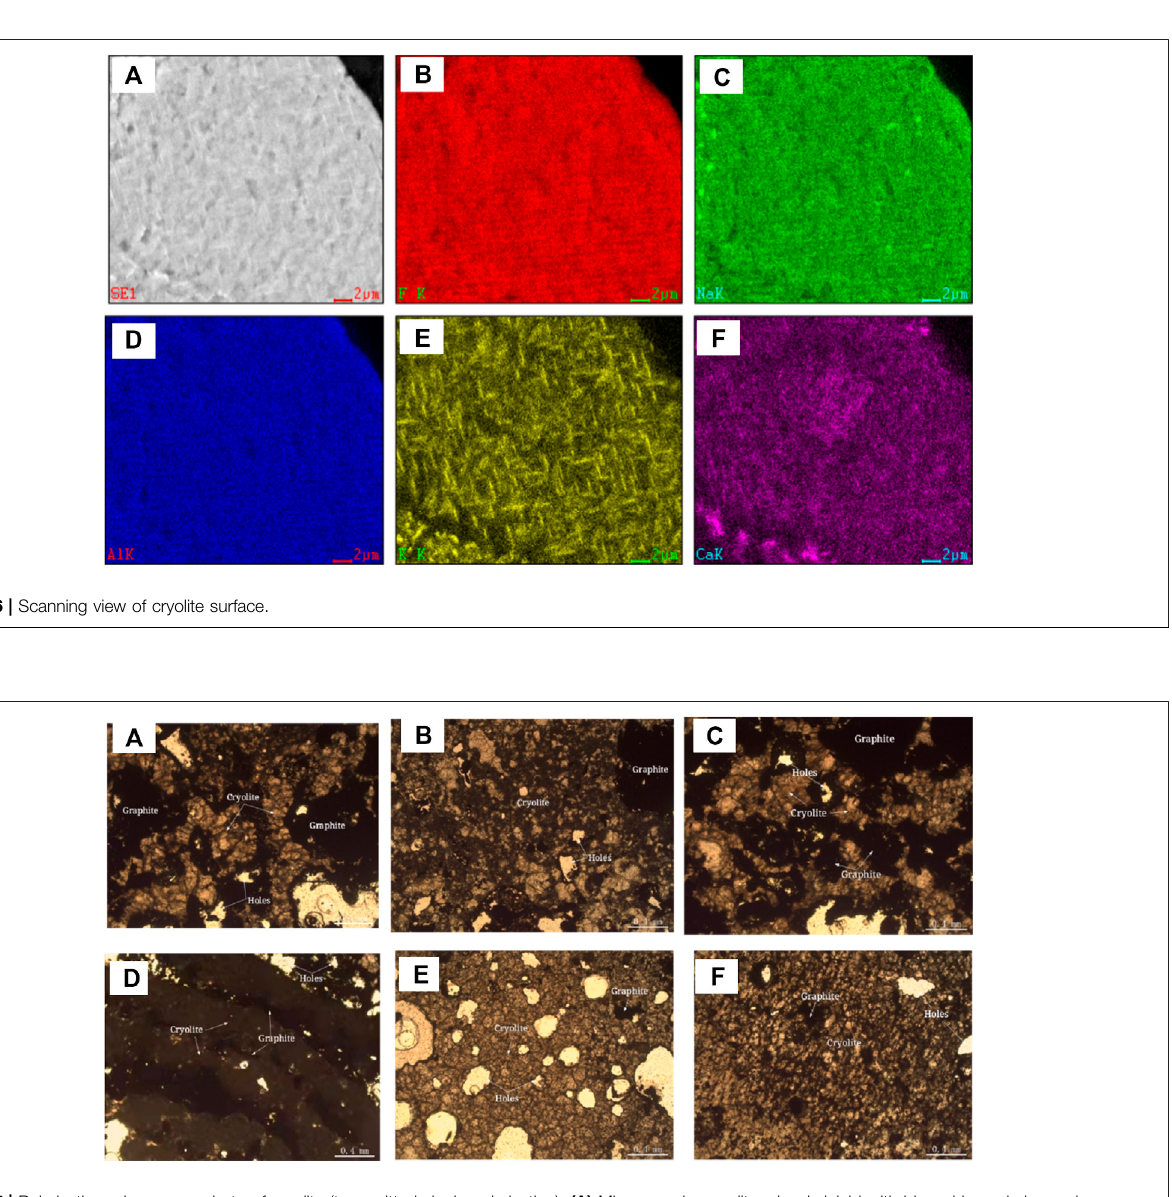
FIGURE 7 | Polarization microscope photo of cryolite (transmitted single polarization). (A) Microgranular cryolite, closely inlaid with blurred boundaries and embeddedwithgraphiteaggregates. (B) Themicrogranularicecrystalsarealternatelydistributedwithmicriticcryolite. (C) Graphiteaggregatesaredistributedincryolite. (D) The cryolite is in the form of mud-microcrystalline, and the graphite aggregates are in the form of intermittent strips, which are distributed in the cryolite. (E) microscopic granular cryolite is shaped granular, particles are closely inlaid, the boundaries are black and thick, and there are more cavities. (F) Microgranular cryolite is amorphous and alternately distributed with micritic